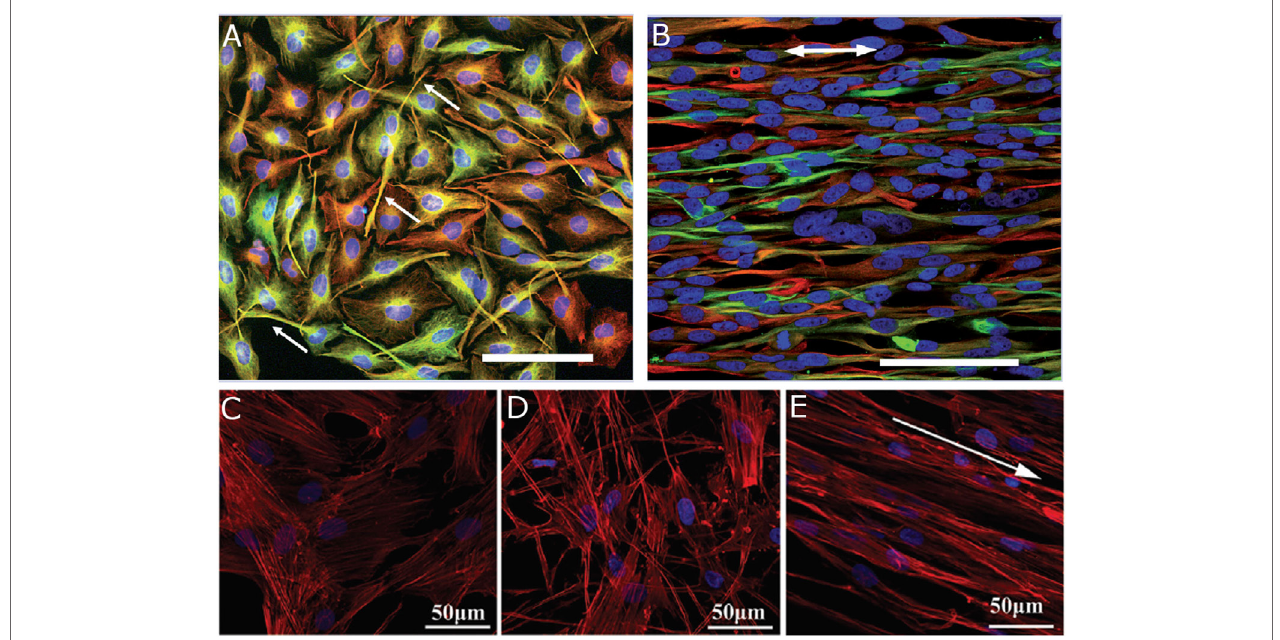
FiGURe 4 | Human astrocytoma cell line U373 cultured on (A) poly- l -lysine substrate for 4 days and (B) aligned PCL fibers for 7 days. Arrows indicate (A) process extensions and (B) fiber orientation. Reproduced with permission of Gerardo-Nava et al. (2009), Copyright 2009, Future Medicine Ltd. Human umbilical cord mesenchymal stem cells cultured on (C) tissue culture plastic, (D) randomly oriented fibrin fibers, and (e) aligned fibrin fibers for 1 day. Arrow indicates fiber orientation. Reproduced with permission of Yao et al. (2016), Copyright 2016, Royal Society of Chemistry. (A,B) Cell nuclei (blue), GFAP (green), vimentin (red), and scale bars = 100 µm. (C–e) Cell nuclei (blue) and F-actin